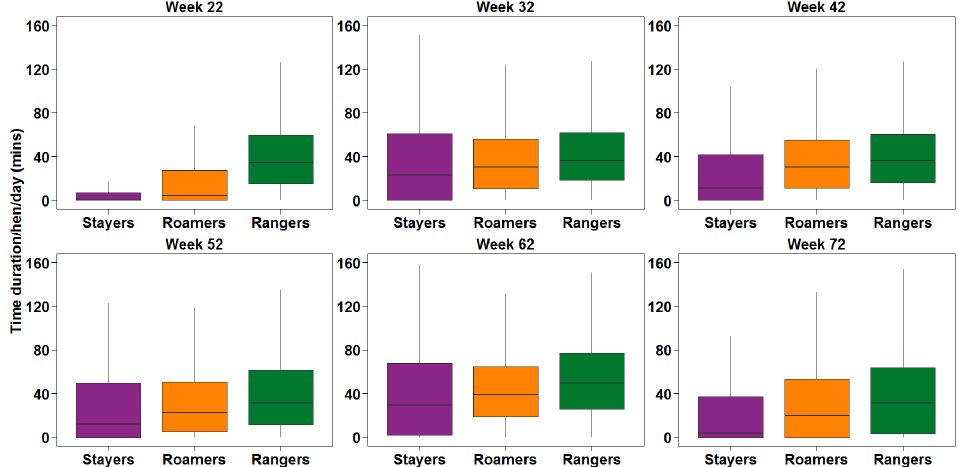
Figure 3. The average duration that the hens categorised as stayers (purple), roamers (orange), and rangers (green) spent on the range when the animals were 22, 32, 42, 52, 62 and 72 weeks of age. The data shown here are pooled from 5 flocks which served as replicates for statistical analysis.